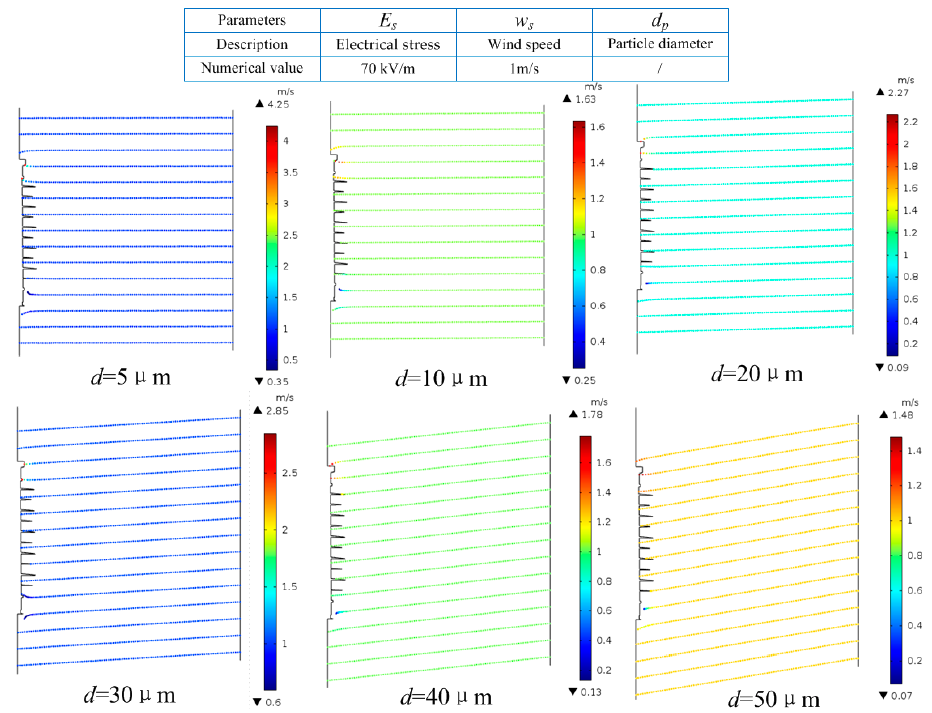
Figure 7. Particle movement with different particle diameter.